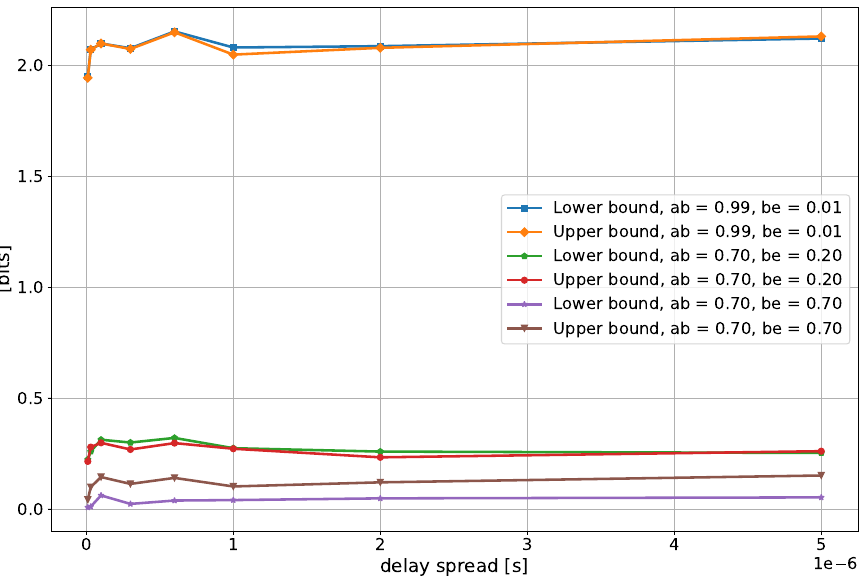
Figure 11. Secrecy key rate as a function of the delay spread of the channel of Alice and Bob, for different values of the correlation and with one filter. In the legend, “ab” and “be” stand for the Alice–Bob correlation and Bob–Eve